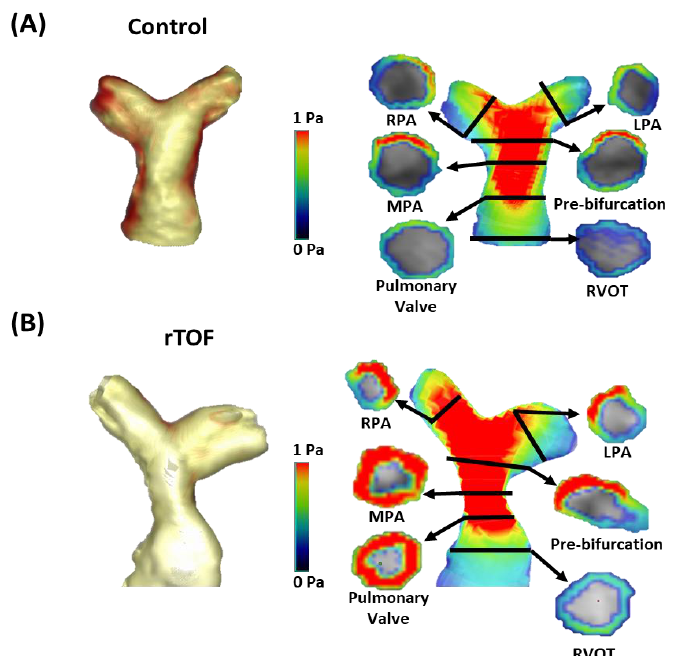
Figure 6. Wall shear stress analysis plane assessment along the pulmonary artery. Panel ( A ) shows the example of a healthy volunteer and Panel ( B ) shows the corresponding measurements for a patient with repaired Tetralogy of Fallot (rTOF). RVOT: right ventricle outflow tract; MPA: main pulmonary artery; RPA: right pulmonary artery; LPA: left pulmonary artery. Remark that the visualization threshold affects lumen thickness representation in the analysis software, but it does not impact the quantification.